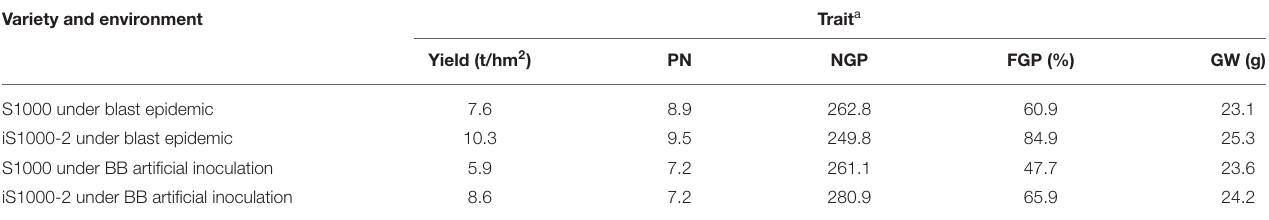
TABLE 6 | Comparison of yield and yield components between the iS1000 and the original Super 1000 under disease stresses. Variety and environment Trait